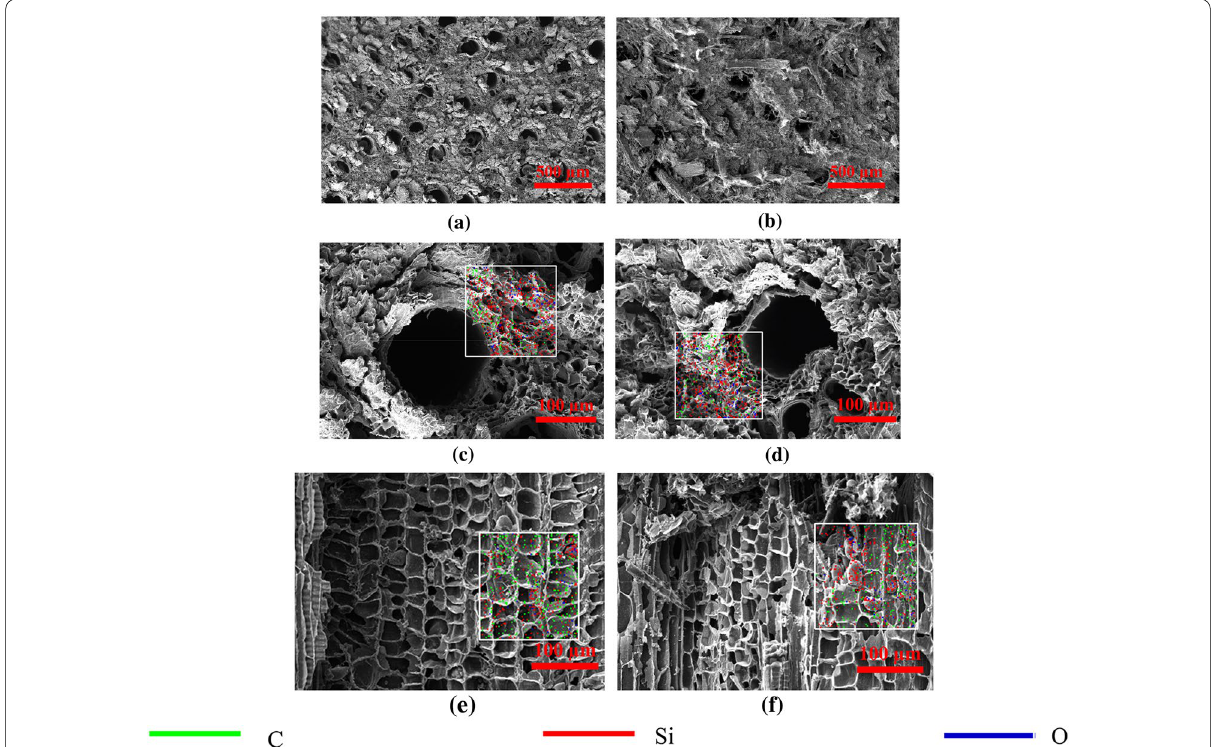
Fig. 5 The FESEM image and the corresponding EDX spectrum of R–SiC at different retention times (R–SiC T1500t30 : a , c and e ; R–SiC T1500t60 : b , d and f